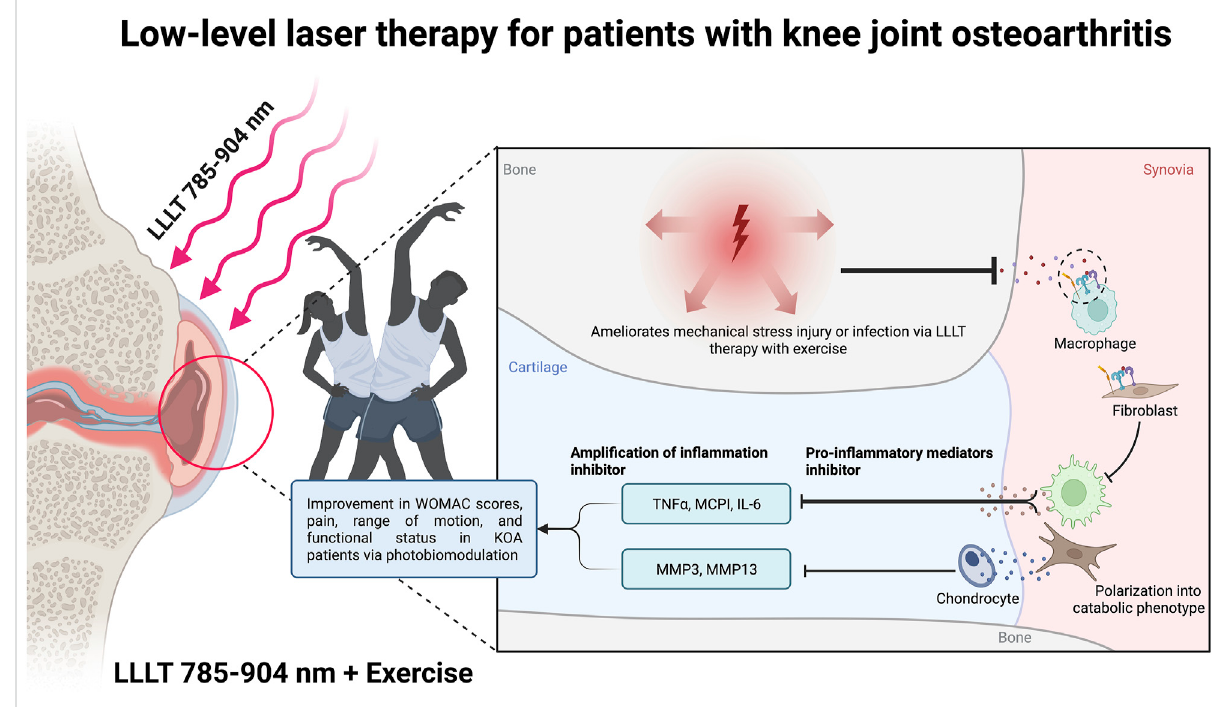
FIGURE 1 Photobiomodulation mechanism in patients with knee joint osteoarthritis by Low-level laser therapy. Created with BioRender.com premium license by Fahrul